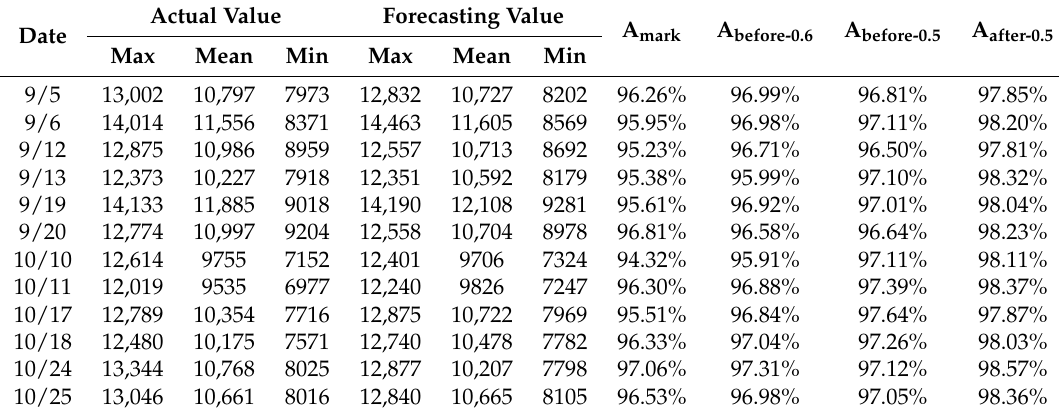
Table 3. Weekend Load Curve Forecast Results in